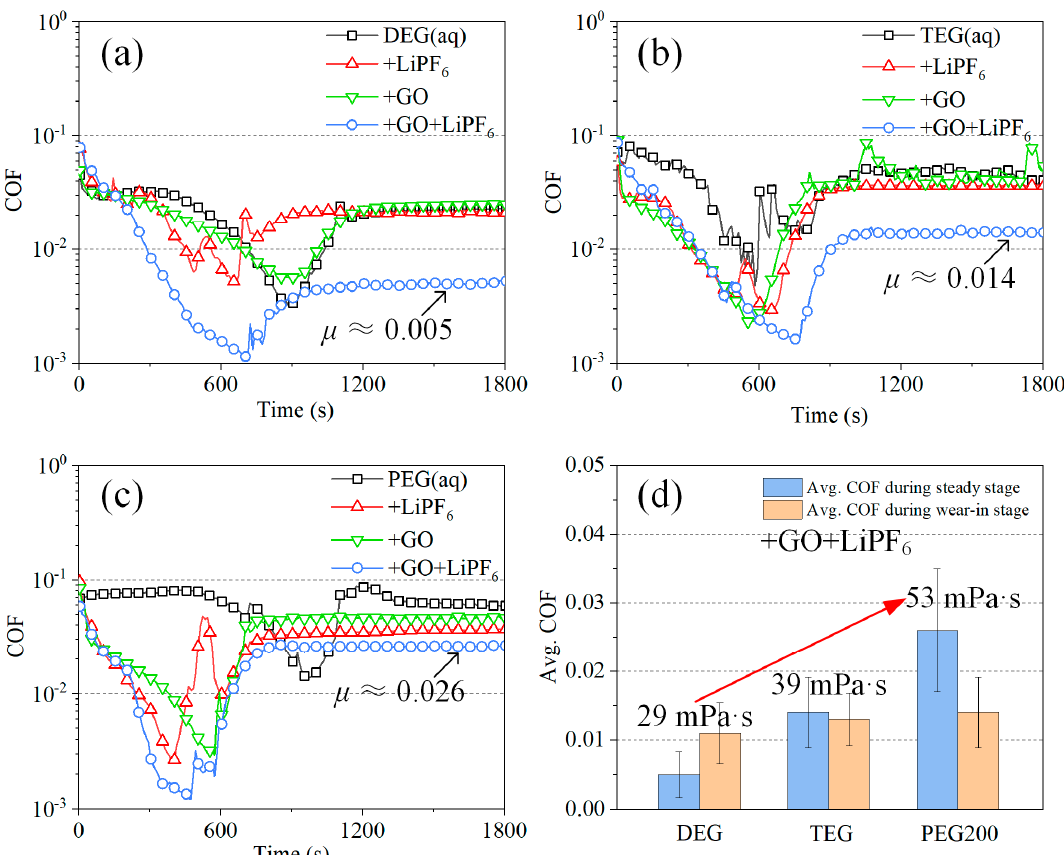
Figure 3. COFs of various DA(aq) acquired at 3 N, 100 mm/s, and 20 μ L, ( a ) DEG(aq), ( b ) TEG(aq), ( c ) PEG(aq), and ( d ) effect of DA viscosities on COFs during wear − in and steady lubrication stages.